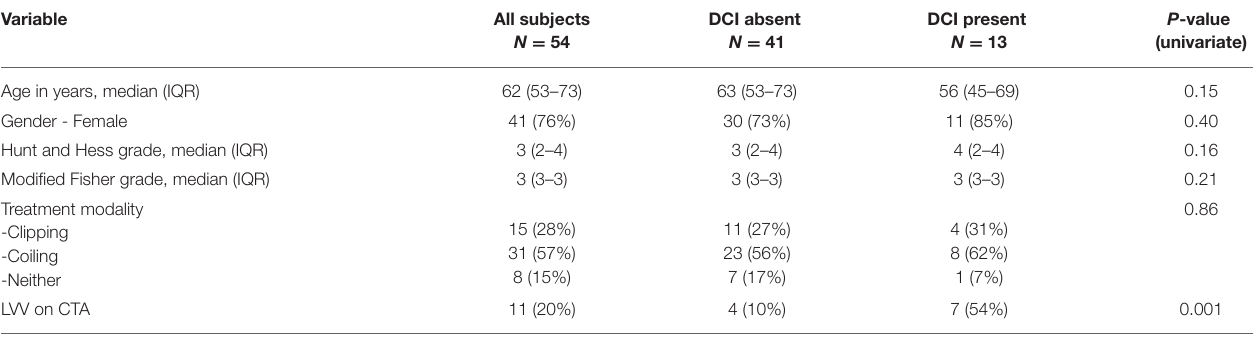
TABLE 1 | Patient baseline characteristics.